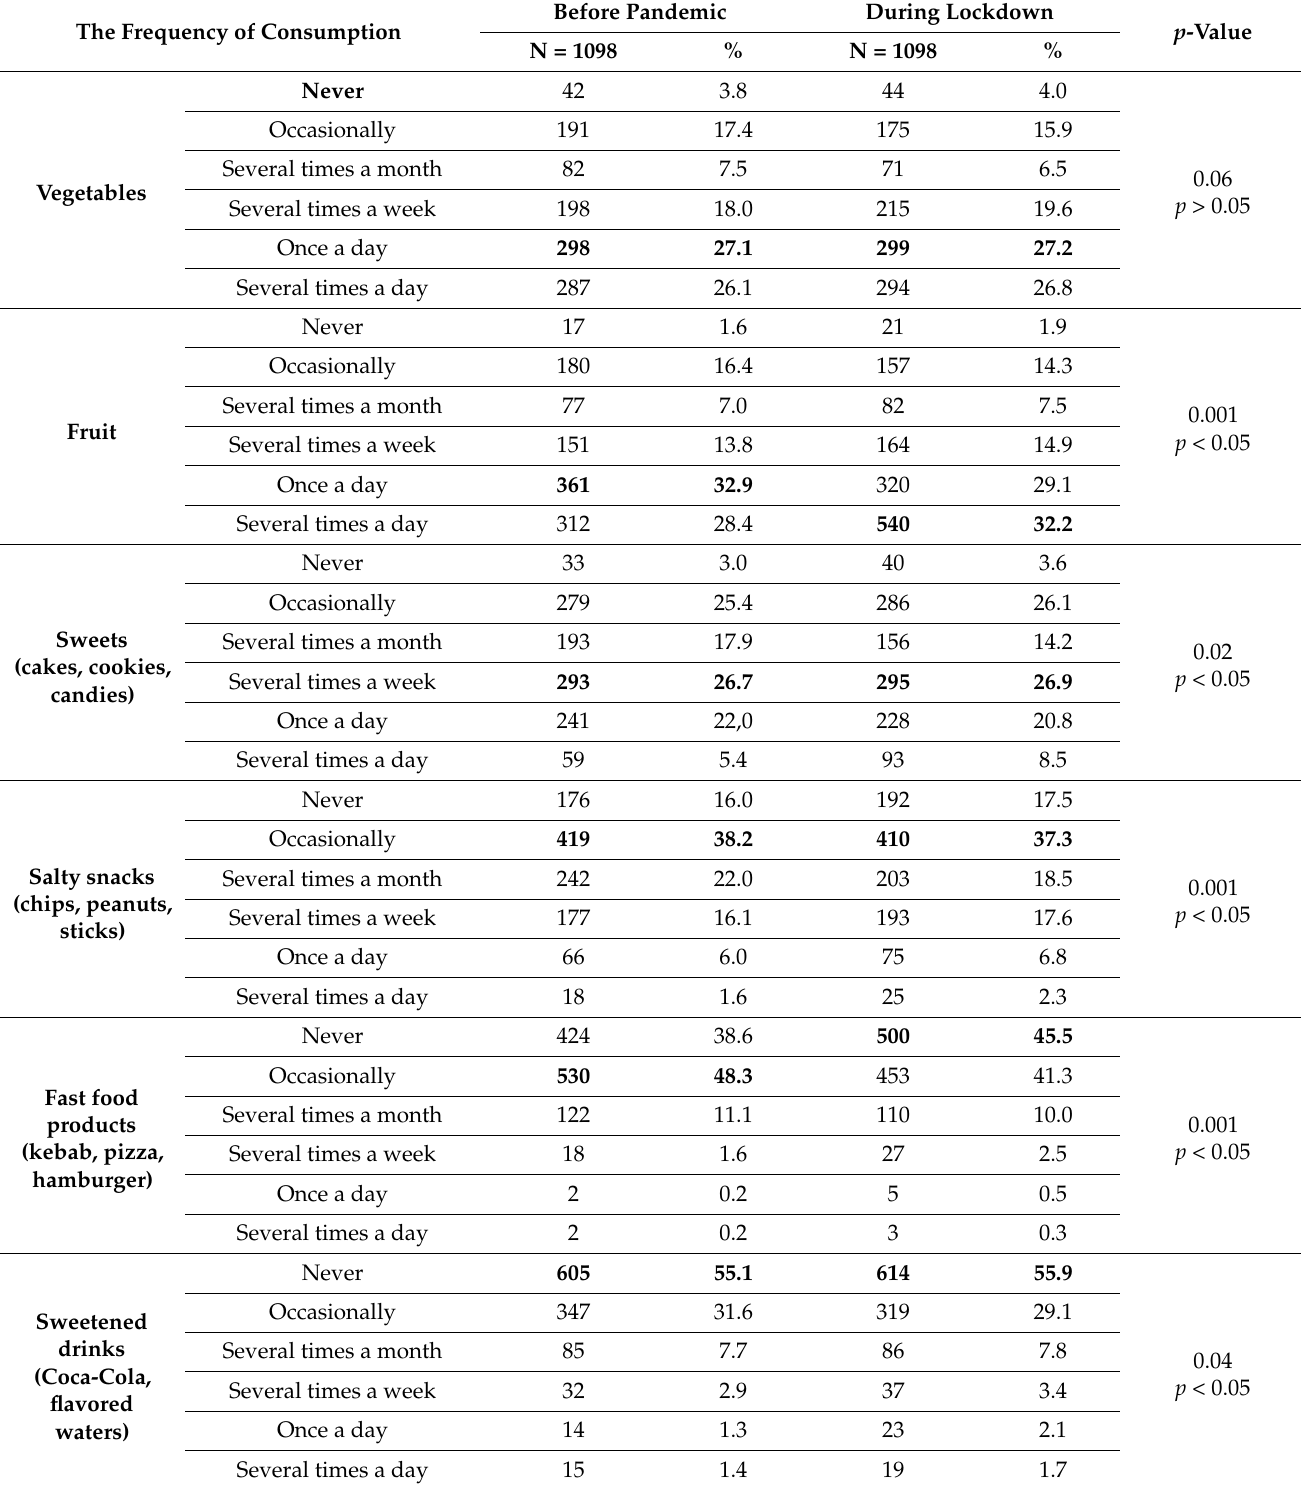
Table 3. Frequency of consumption of selected products by